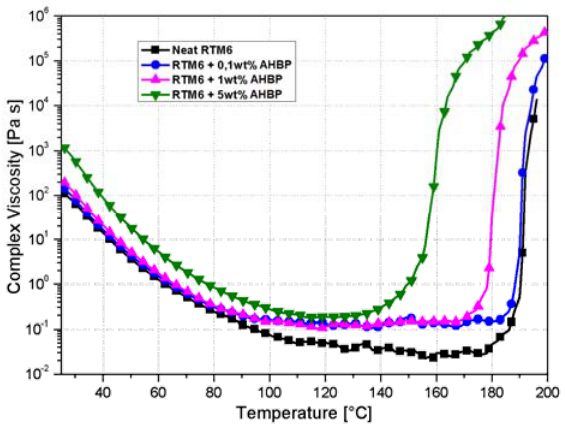
Figure 9. Complex viscosity vs. temperature for the neat system and for suspensions with 0.1, 1, and 5 wt% of AHBP.